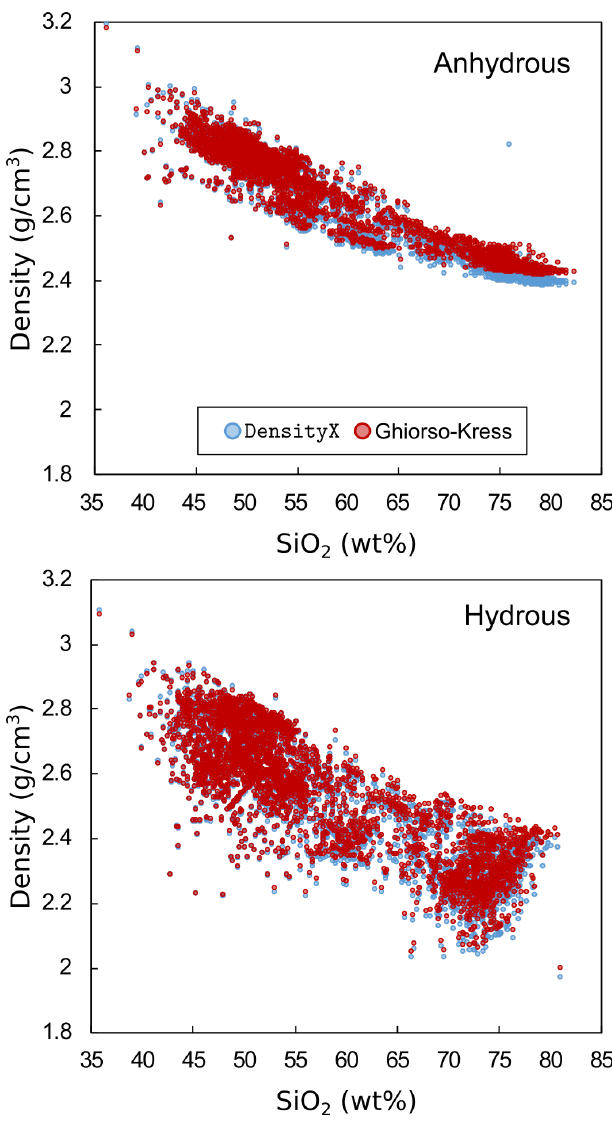
Figure A1: Comparison of densities of over 3,000 melt inclusions (normalized to 100%) from the GEOROC database calculated with DensityX (blue dots, same values as plotted in Figure 1) and with DensityX but using the Ghiorso-Kress expanded database (red dots). The average di ff erence in values calculated with these two databases is < 1% of the density value, with a max- imum di ff erence for any sample shown here of